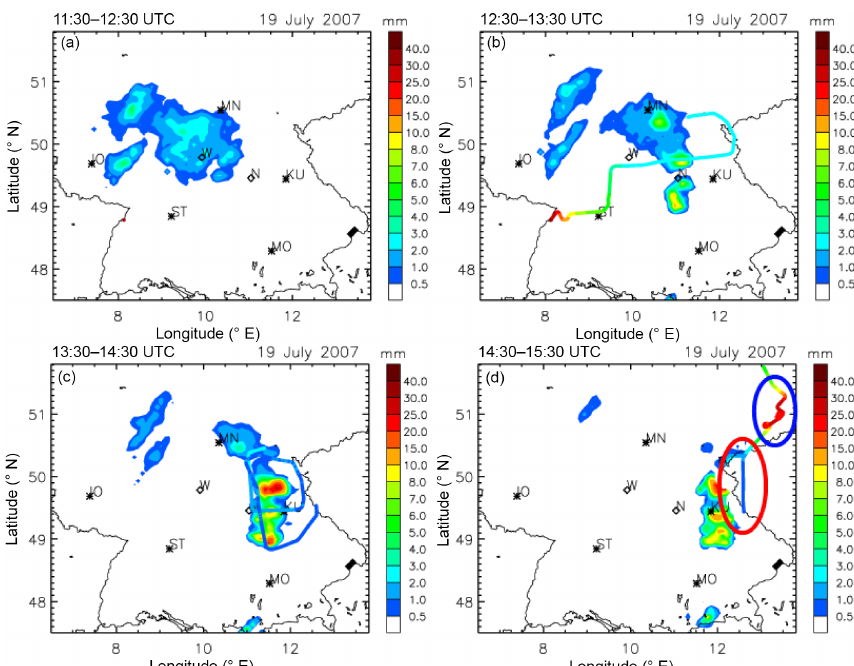
Figure 5. (a–d) : RADOLAN data of the German weather service. Precipitation intensity is colour coded in millimetres per hour. The flight tracks are also shown (red: low flight levels, blue: high flight levels). The red marked area in the lower panel shows the outflow region, the blue one the inflow region in the boundary layer nearby Dresden. Data were provided by M. Zimmer with permission of E. Weigel (German weather